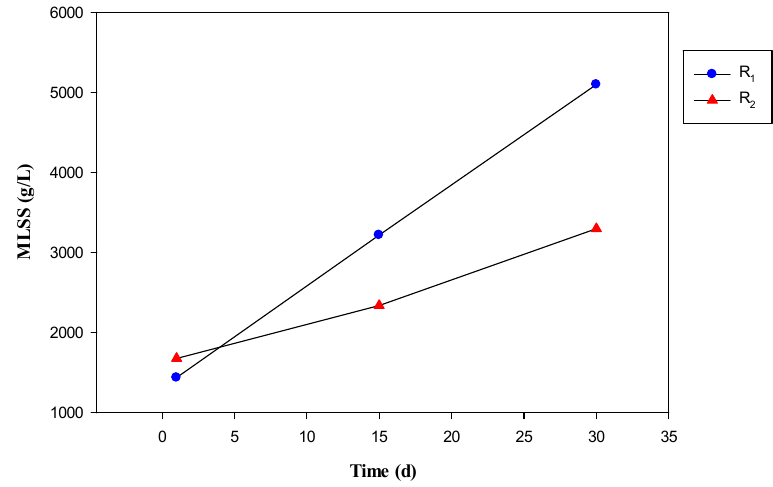
Fig. 3. MLSS concentration in MBR